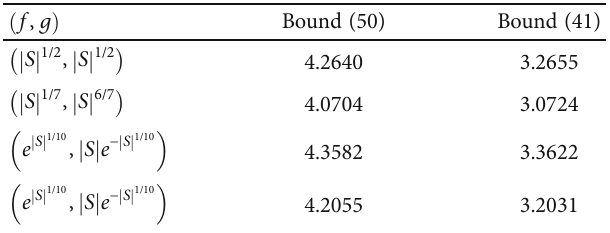
Table 1: Bounds (41) and (50) for di ff erent choices of f and g in